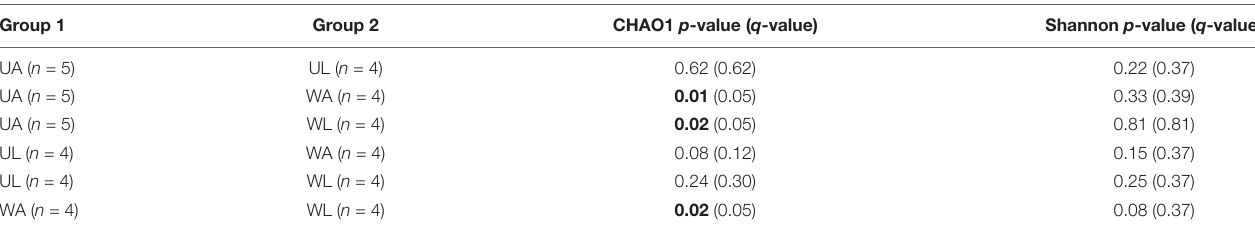
( Table 3 ). Unweighted UniFrac measured the